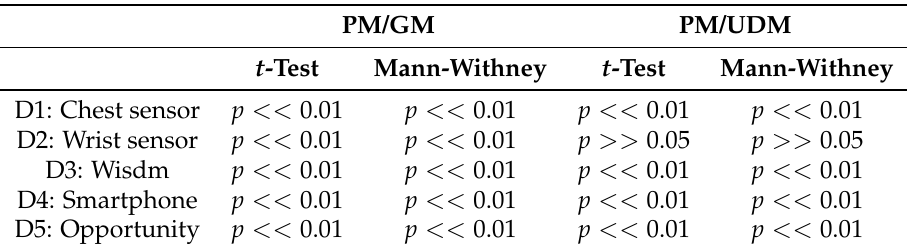
Table 5. Results of the statistical tests. PM: Personalized model; GM: General model; UDM: User-dependent